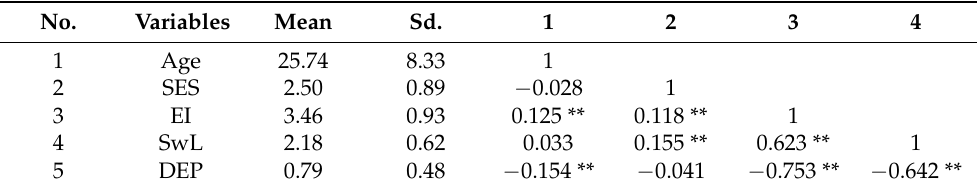
Table 3. Correlation, mean, and standard deviation